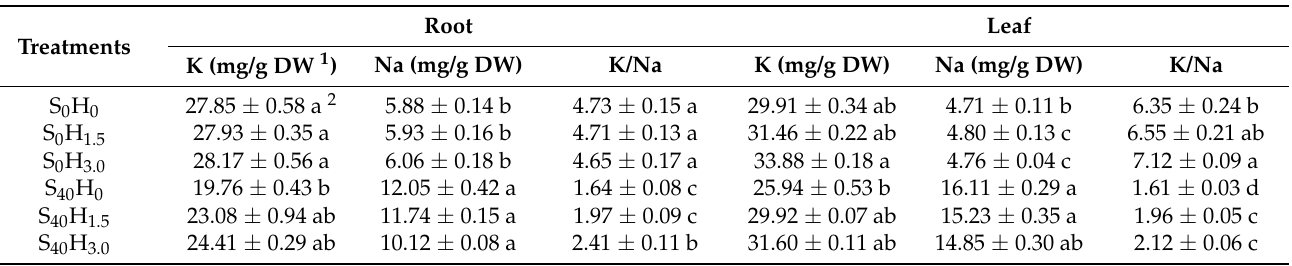
Table 2. Influence of salt stress and sulfur supplementation on sodium, potassium, and potas- sium/sodium ratio in lettuce roots and